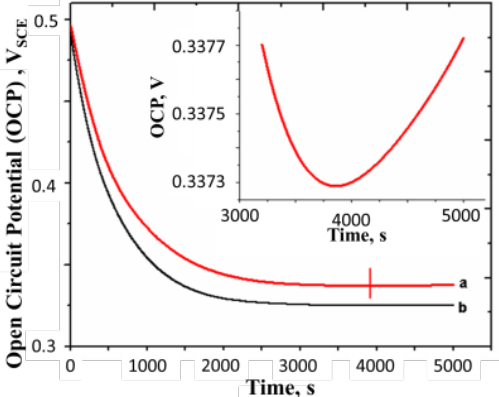
Figure 8. Open circuit potential curve of a polyaniline film which is pre-oxidized to a potential much greater than the equilibrium potential (0.39 V SCE ). ( a ) Without nitrogen bubbling; ( b ) with nitrogen bubbling. Concentration of H 2 SO 4 = 0.5 M, surface mass density of the film = 16.3g m −2 and temperature = 25 °C. All potentials are reported with respect to SCE. Inset shows the OCP in the region around the turning point marked on curve a.